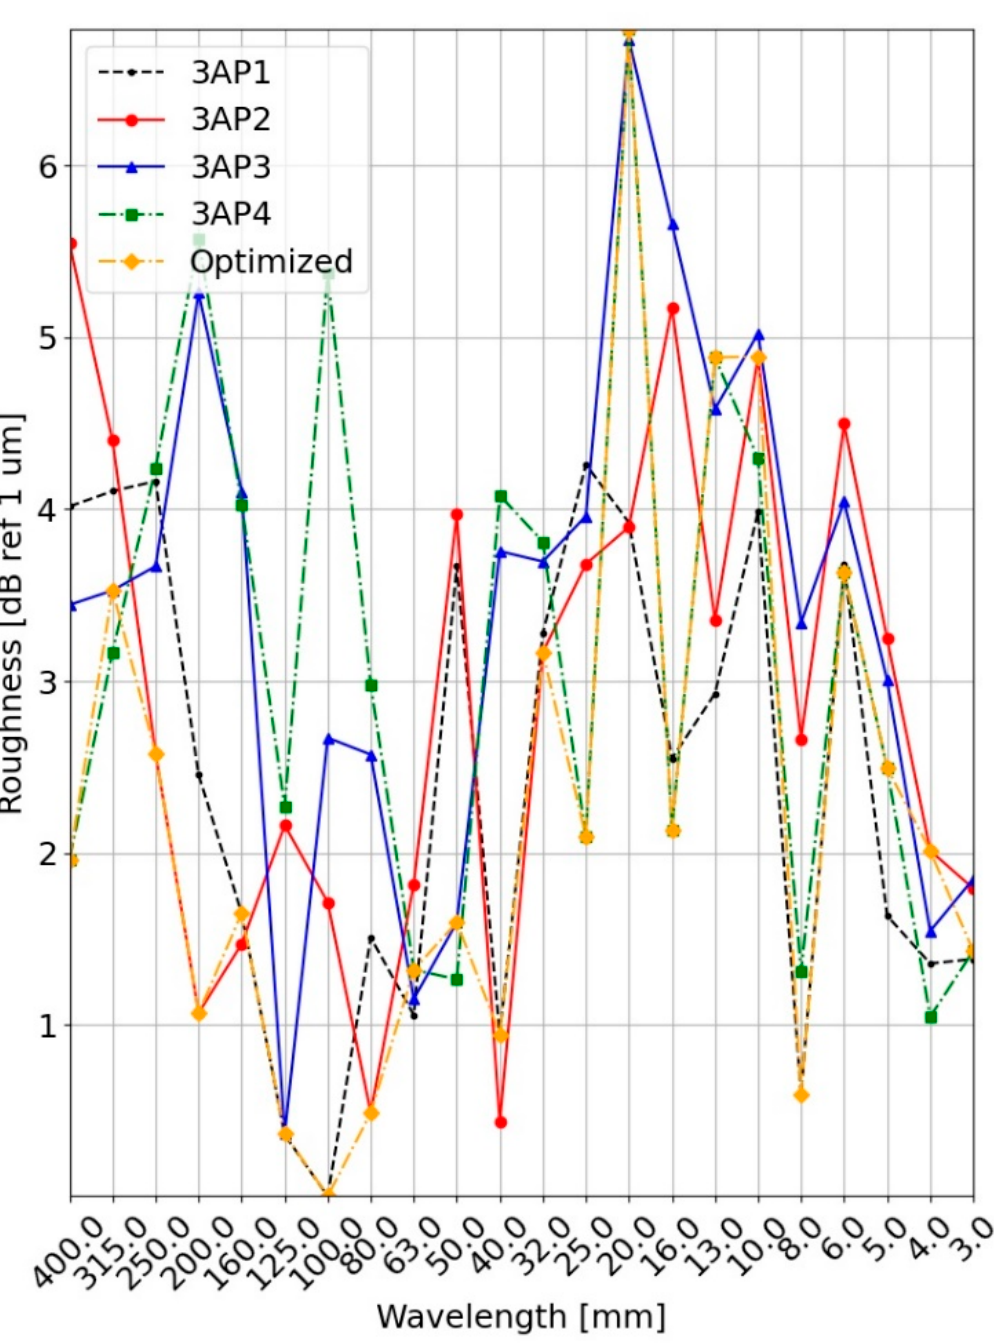
Figure 10. Absolute error of acoustic roughness for an undisturbed measurement and comparison of different chord lengths with the optimization approach